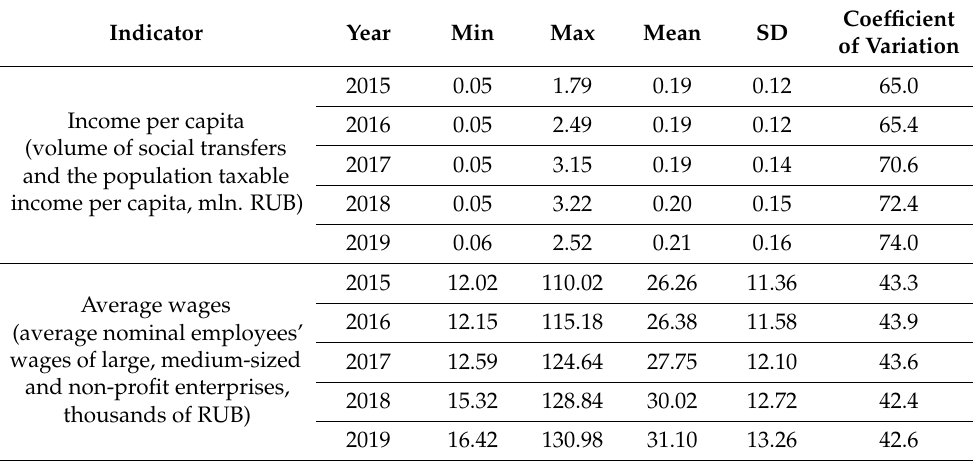
Table 1. Descriptive